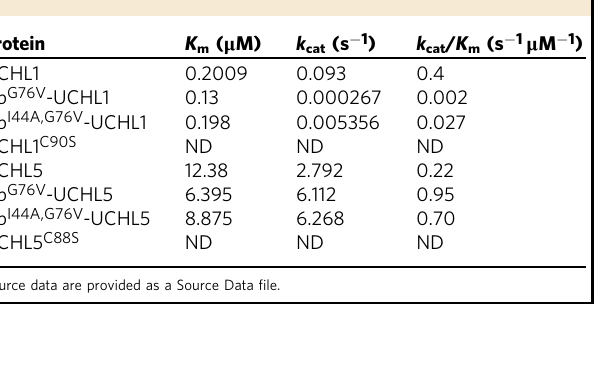
Table 1 UCHL1 and UCHL5 kinetics table for Ub-Rho110- monoubiquitin experiment.